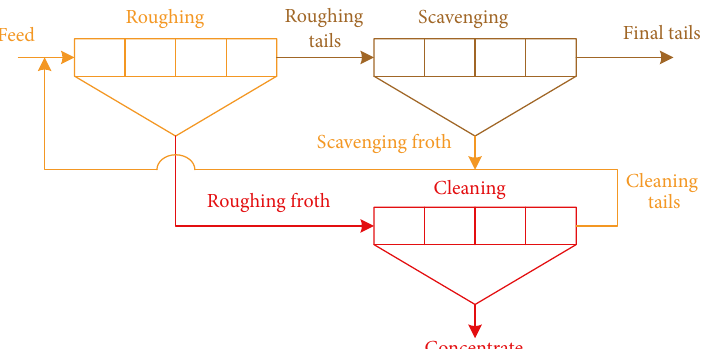
Figure 1: Flow-diagram of a sulphur flotation